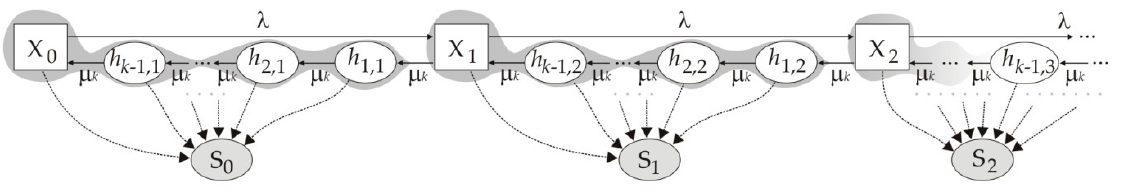
Figure 6. Sums of probability of real and abstract states.